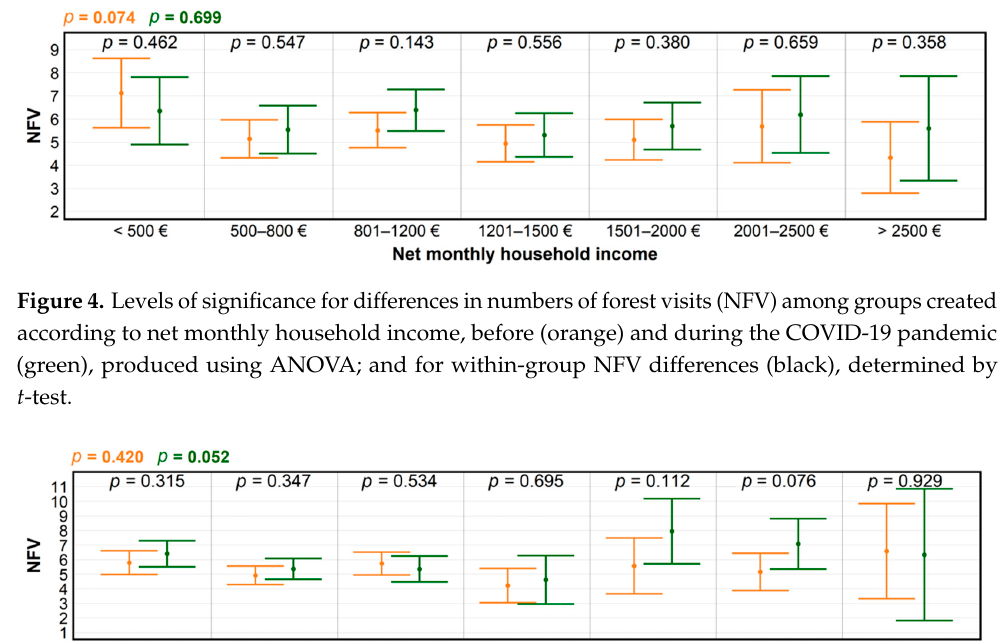
Figure 6. Levels of significance for differences in numbers of forest visits (NFV) between men and women, before (orange) and during the COVID-19 pandemic (green), produced using ANOVA; and for within-group NFV differences (black), determined by t -test. 3.3. Role of Age Finally, age as a factor explained a major part of the NFV variability (Figure 7). While there were no detectable differences in the numbers of visits according to age prior to the